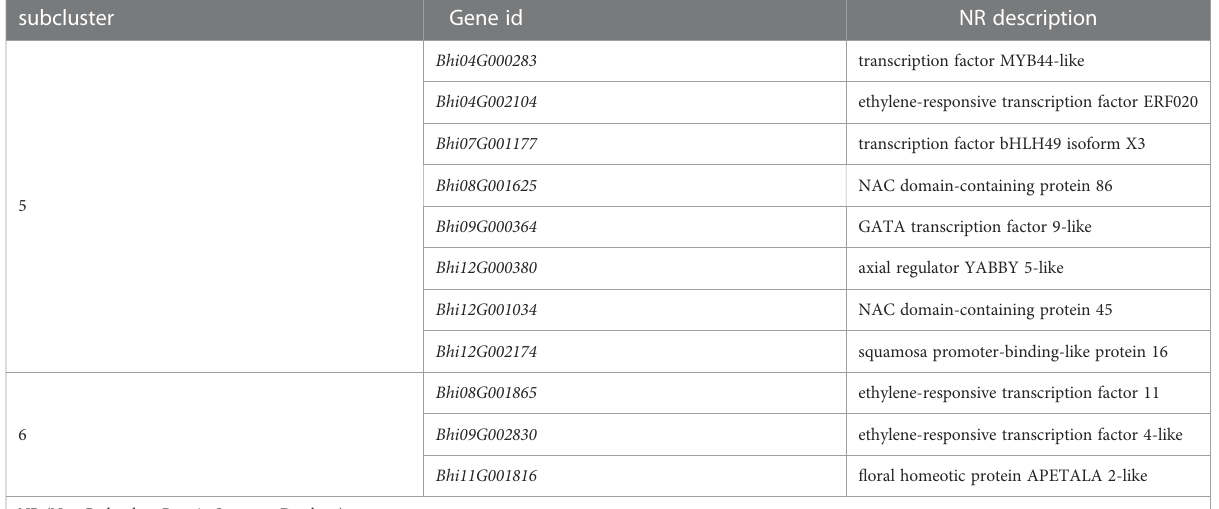
TABLE 5 Genes in subcluster 5 and 6 of TF genes.